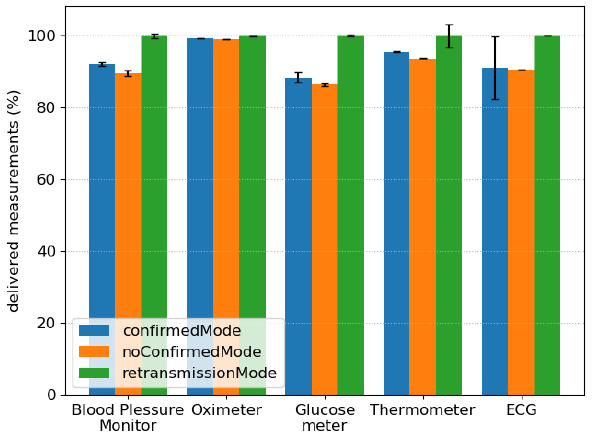
Figure 9. Measurement packets successfully delivered to the manager per node.